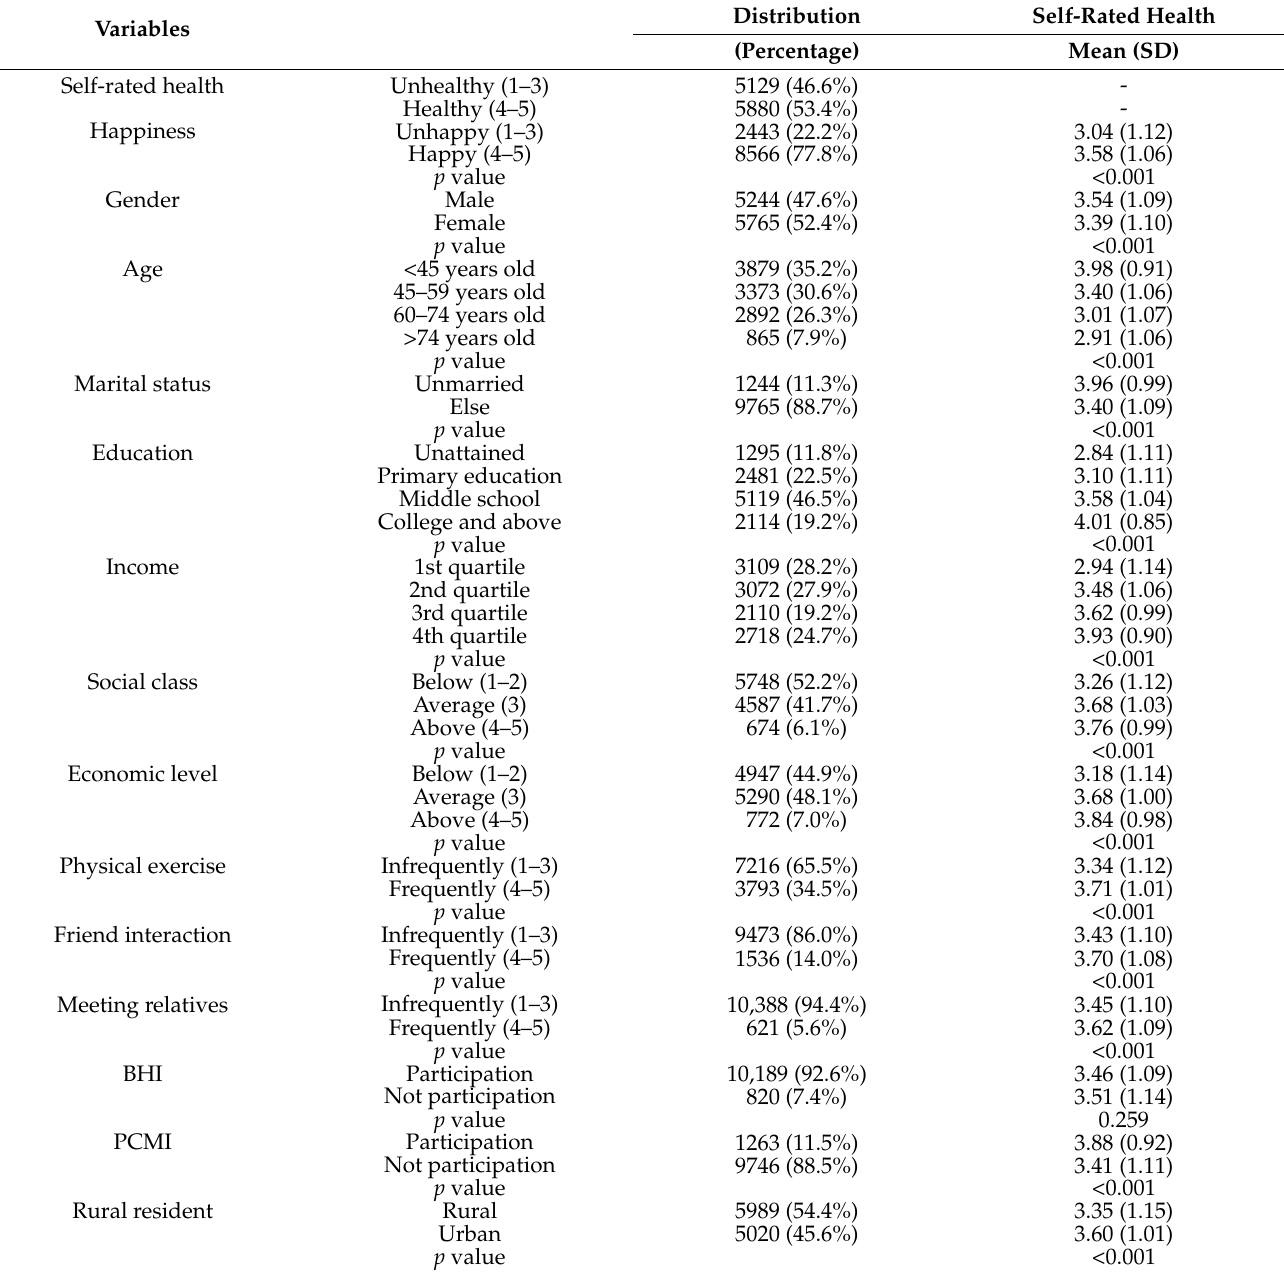
Table 2. Descriptive statistics of different variables ( n = 11,009). Abbreviations: basic health